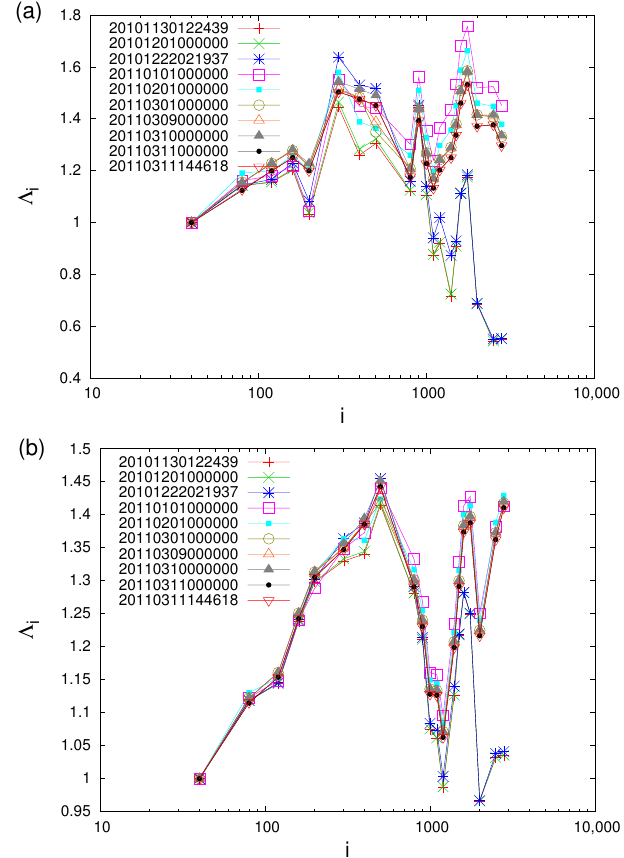
Figure 23. The same as Figure 22, but when studying only the M JMA ≥ 4.0 EQs. since 1 January 2010 ( a ) and 1 January 2006 ( b ) Taken from Ref.